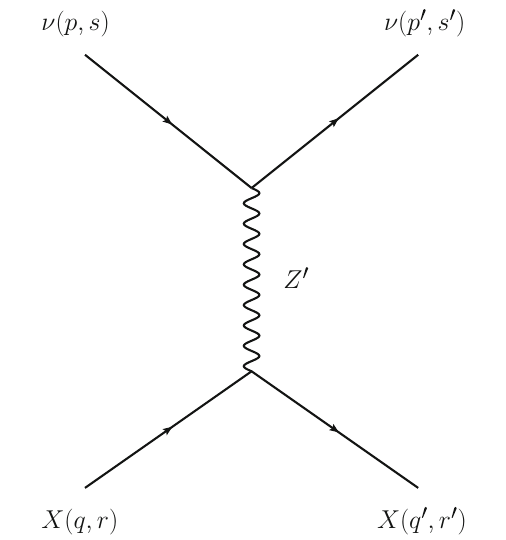
Fig. 2 Feynmandiagramrepresentingtheinteractionbetweenelectron neutrinos ( ν ) and DM particles ( X ) through a Z (cid:3) boson mediator